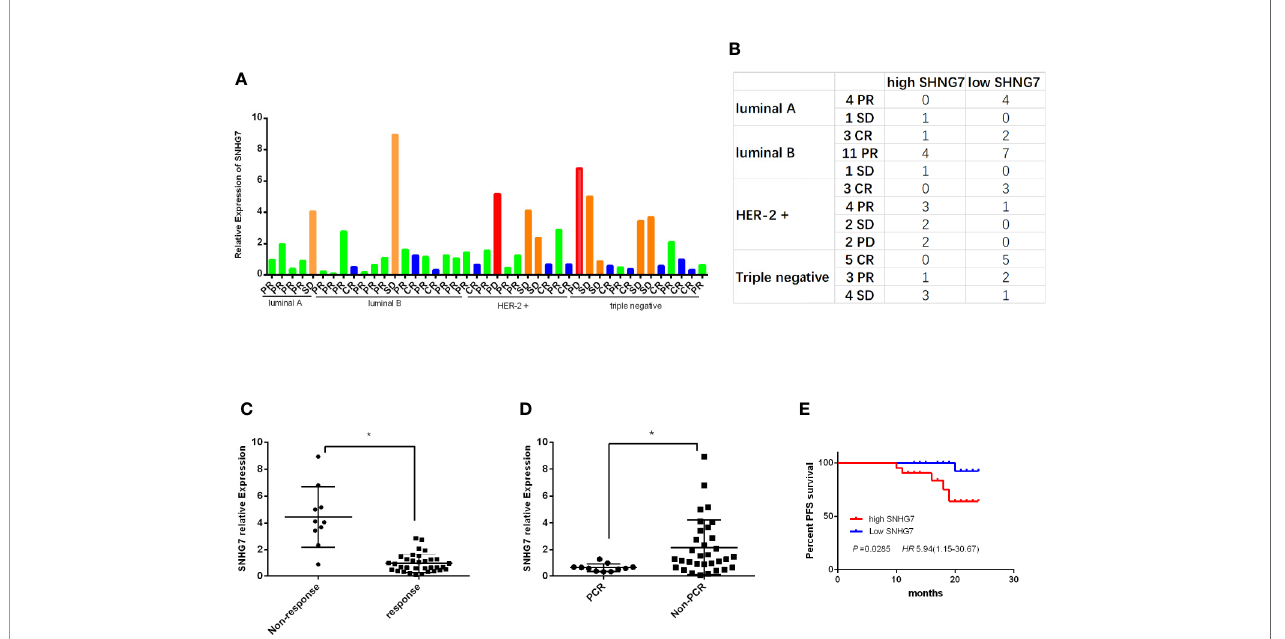
FIGURE 1 | High expression of SNHG7 was correlated with an adverse response to NCT and poor RFS. (A, B) The relative SNHG7 expressions in BC patients with different molecular subtypes and different response to NCT, including complete response (CR), partial response (PR), stable disease (SD) and progression disease (PD). (C) The relative SNHG7 expression levels were associated with response to NCT. (D) The expression of SNHG7 in the pCR group compared with that in the Non-pCR group. (E) The Kaplan – Meier survival curve of patients with advanced breast cancer classi fi ed as low- and high-SNHG7 groups based on a median expression level of SNHG7. *P <